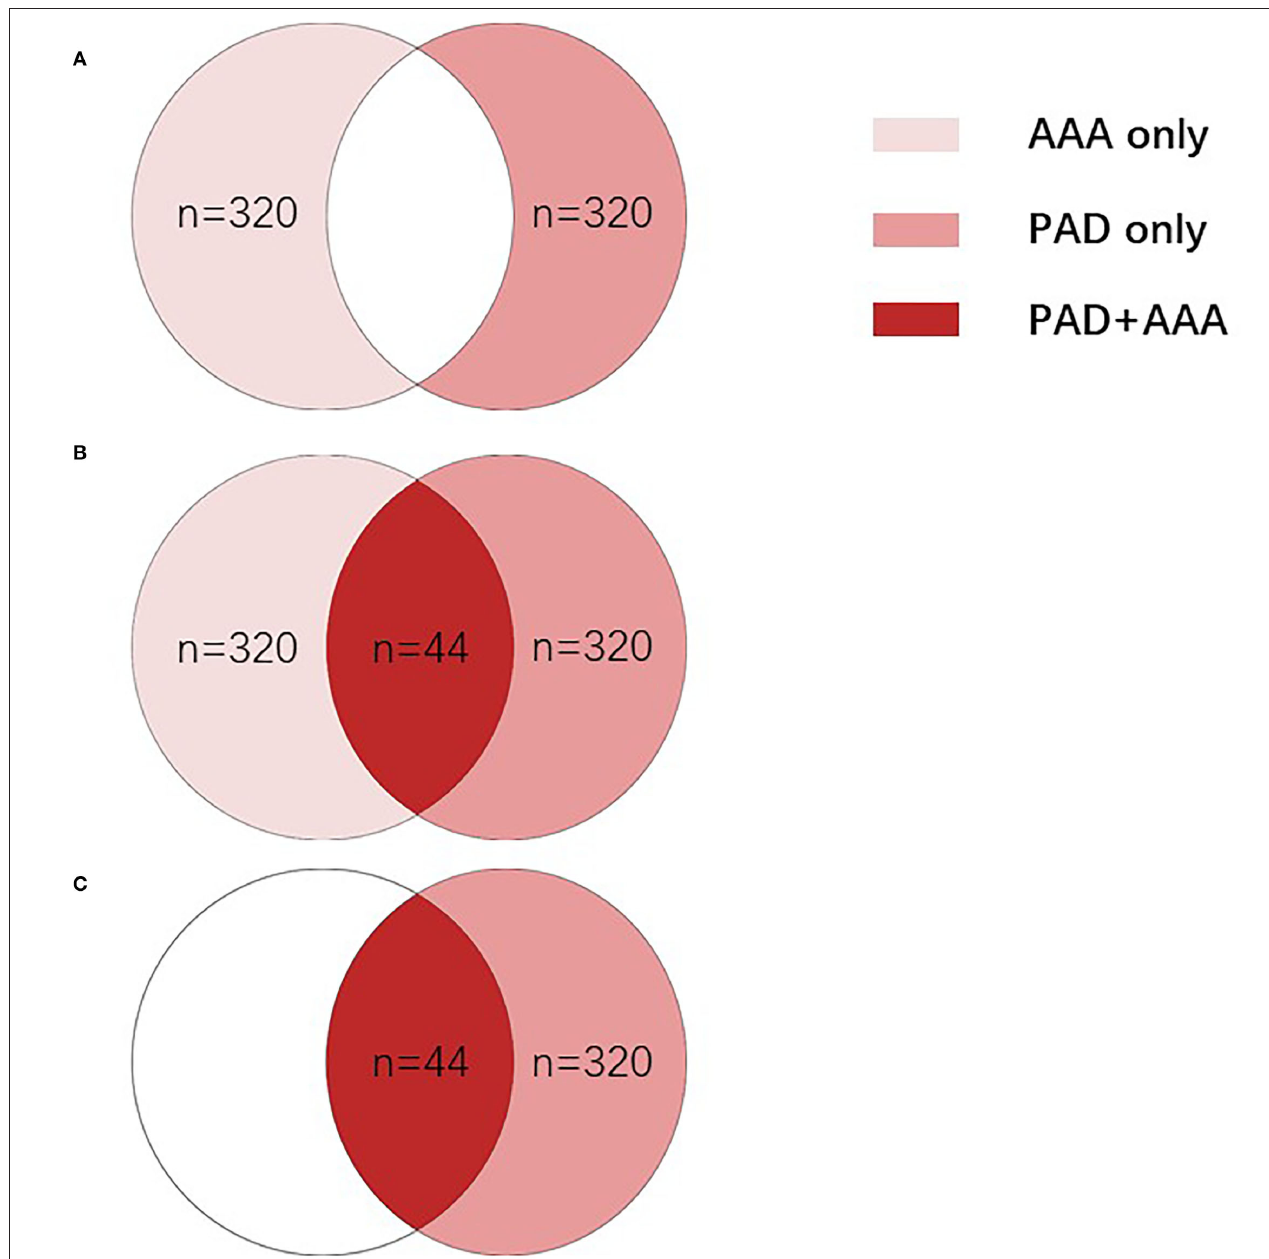
FIGURE 1 | All patients were divided into different groups based on diagnosis. (A) To compare the difference between the PAD group and AAA group, AAA only group ( n = 320), in which patients were diagnosed with AAA without PAD, and the PAD only group ( n = 320), in which patients were diagnosed with PAD without AAA were enrolled. (B) To evaluate whether different indicators can be used to distinguish patients with PAD and patients with AAA, all 684 patients were divided into two groups: the AAA group ( n = 364), in which patients were diagnosed with AAA only ( n = 320) or both AAA and PAD ( n = 44); and the PAD group ( n = 364), in which patients were diagnosed with PAD only ( n = 320) or both PAD and AAA ( n = 44). (C) To evaluate whether d-dimer can clinically distinguish patients with PAD with and without AAA, 364 patients were enrolled, including the PAD only group ( n = 320), in which patients were diagnosed with AAA without PAD and the PAD + AAA group ( n = 44), in which patients were diagnosed with both AAA and PAD. AAA, abdominal aortic aneurysm; PAD, peripheral arterial disease.